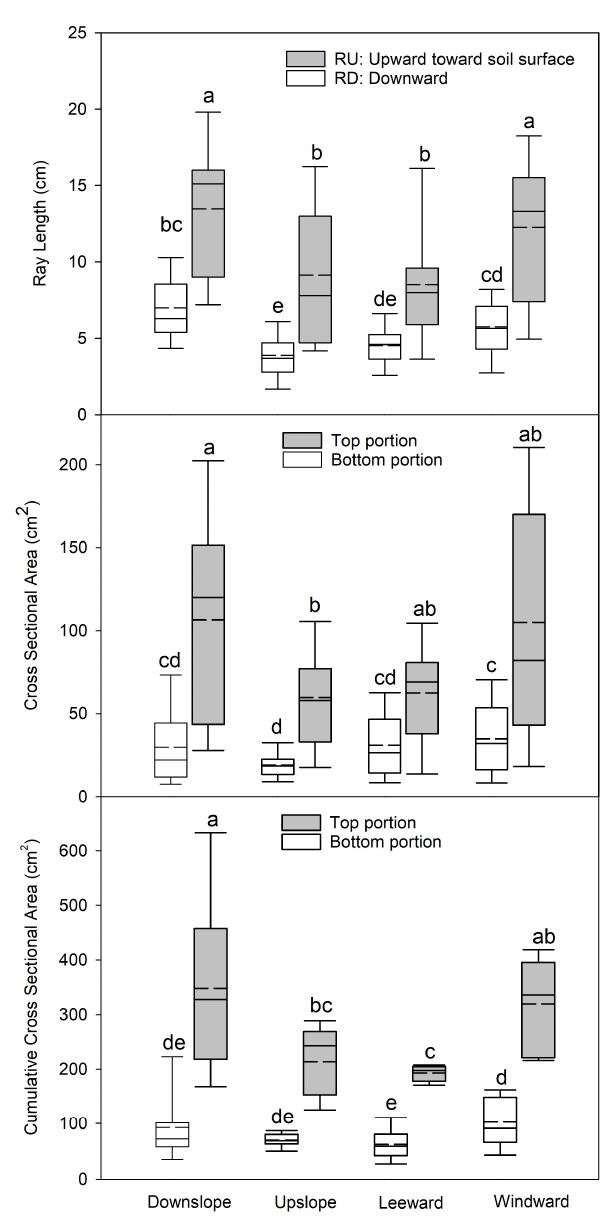
Figure 4. Length of RU (radius oriented upward toward the soil surface), RD (radius oriented downward away from the soil surface), and cross-sectional area (CSA) for the top and bottom portion of the traces left from the lateral roots on the taproot after their removal in the four cardinal quadrants of the 3D root architecture. Letters within each quadrant, and portion combination indicate significant differences ( p < 0.05); vertical boxes represent approximately 50% of the observations and lines extending from each box are the upper and lower 25% of the distribution. Within each box, the solid horizontal line is the median value and the dotted line is the